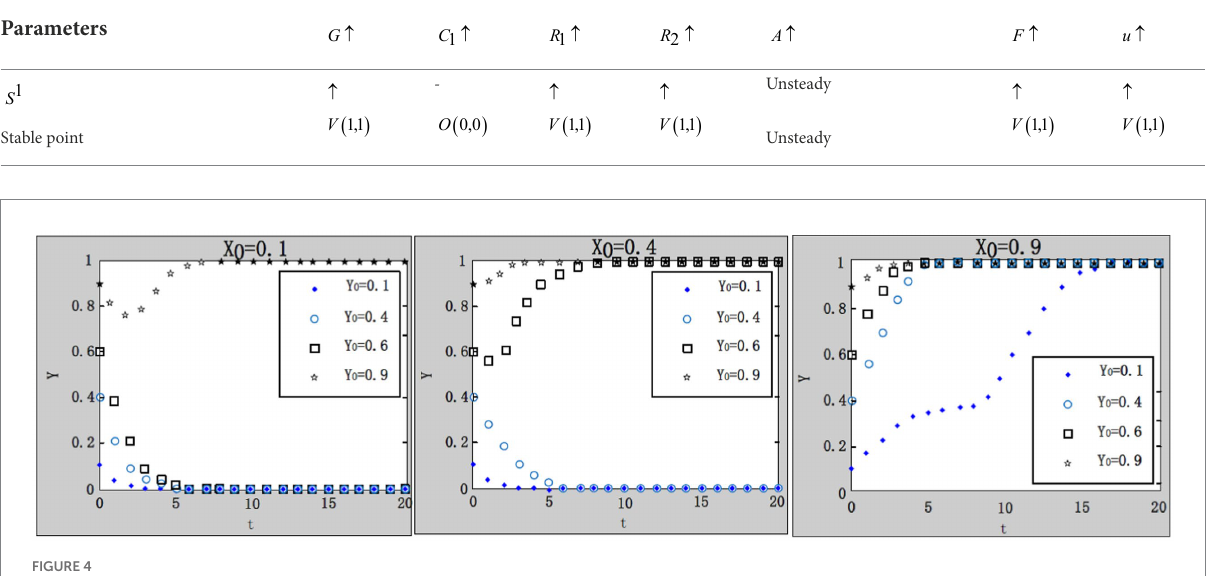
FIGURE 4 Influence of different values of initial proportion on system evolution.